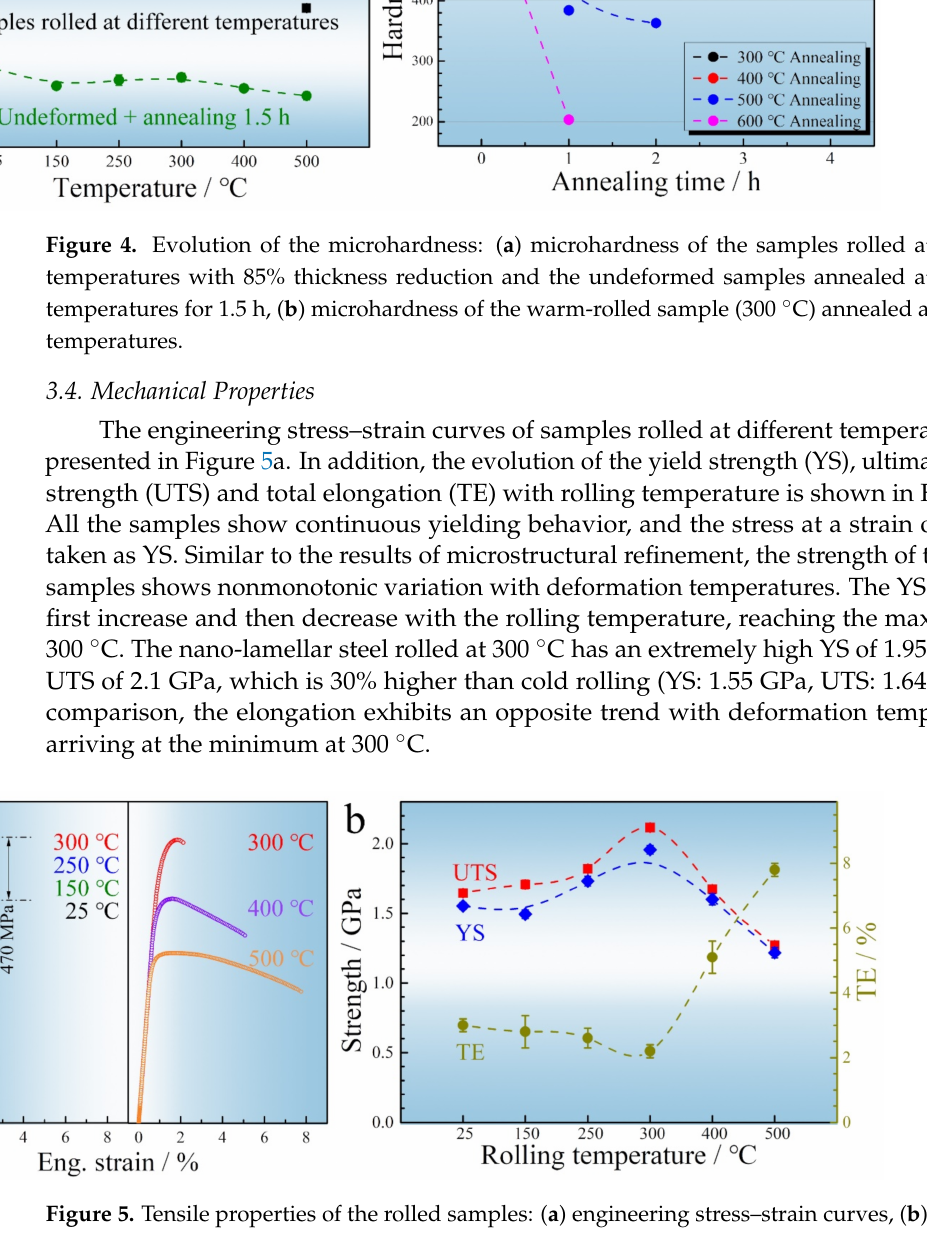
Figure 5. Tensile properties of the rolled samples: ( a ) engineering stress–strain curves, ( b ) evolution of YS, UTS and TE with rolling